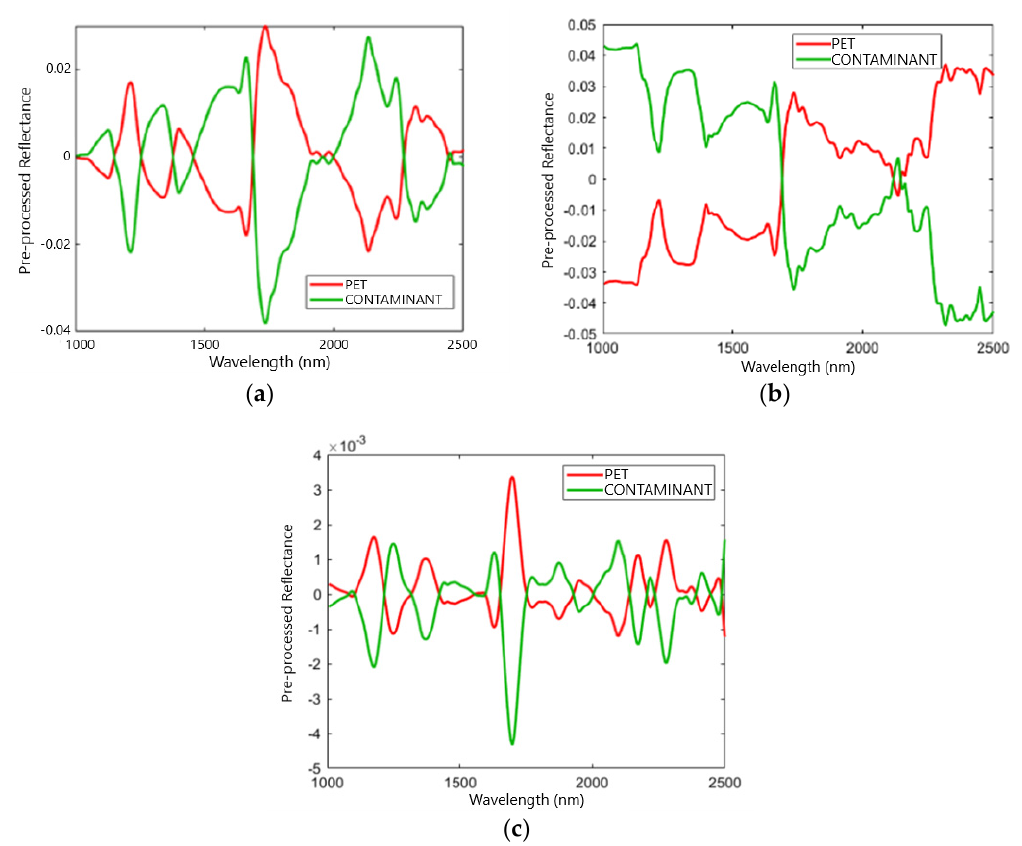
Figure 4. Average pre-processed spectra of PET and contaminant classes in the SWIR range adopting three sets of preprocessing techniques: Set 1: Detrend + Smoothing + MC ( a ); Set 2: SNV + MC ( b ); and Set 3: MSC + Derivative + MC ( c ).